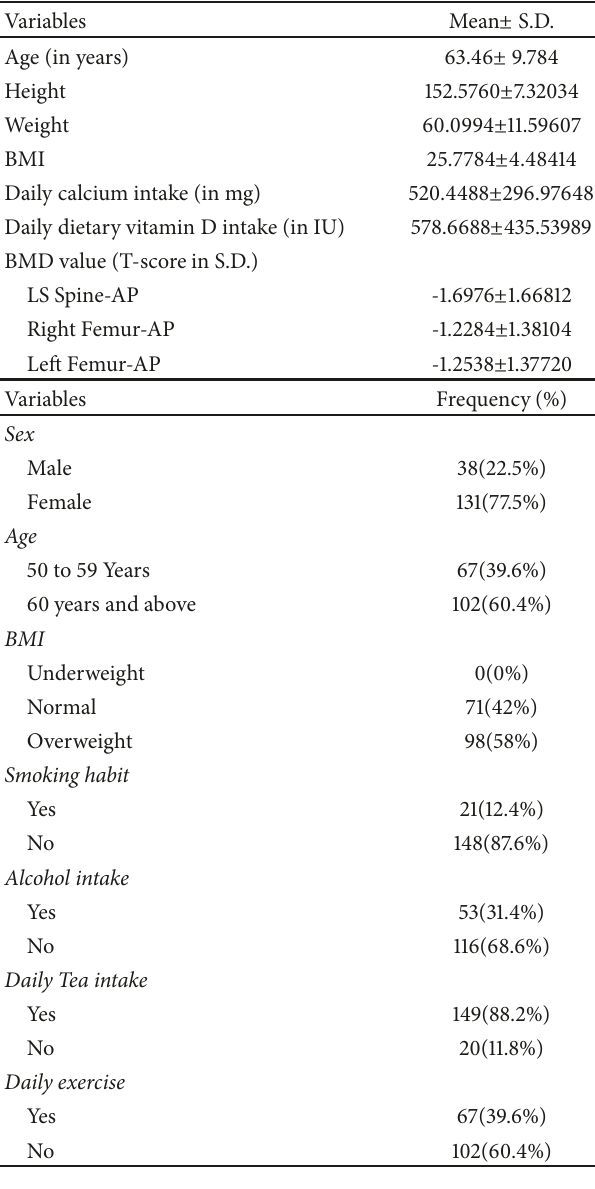
Table 1: Characteristics of respondents (n=169). Table 2: Dietary habit of respondents